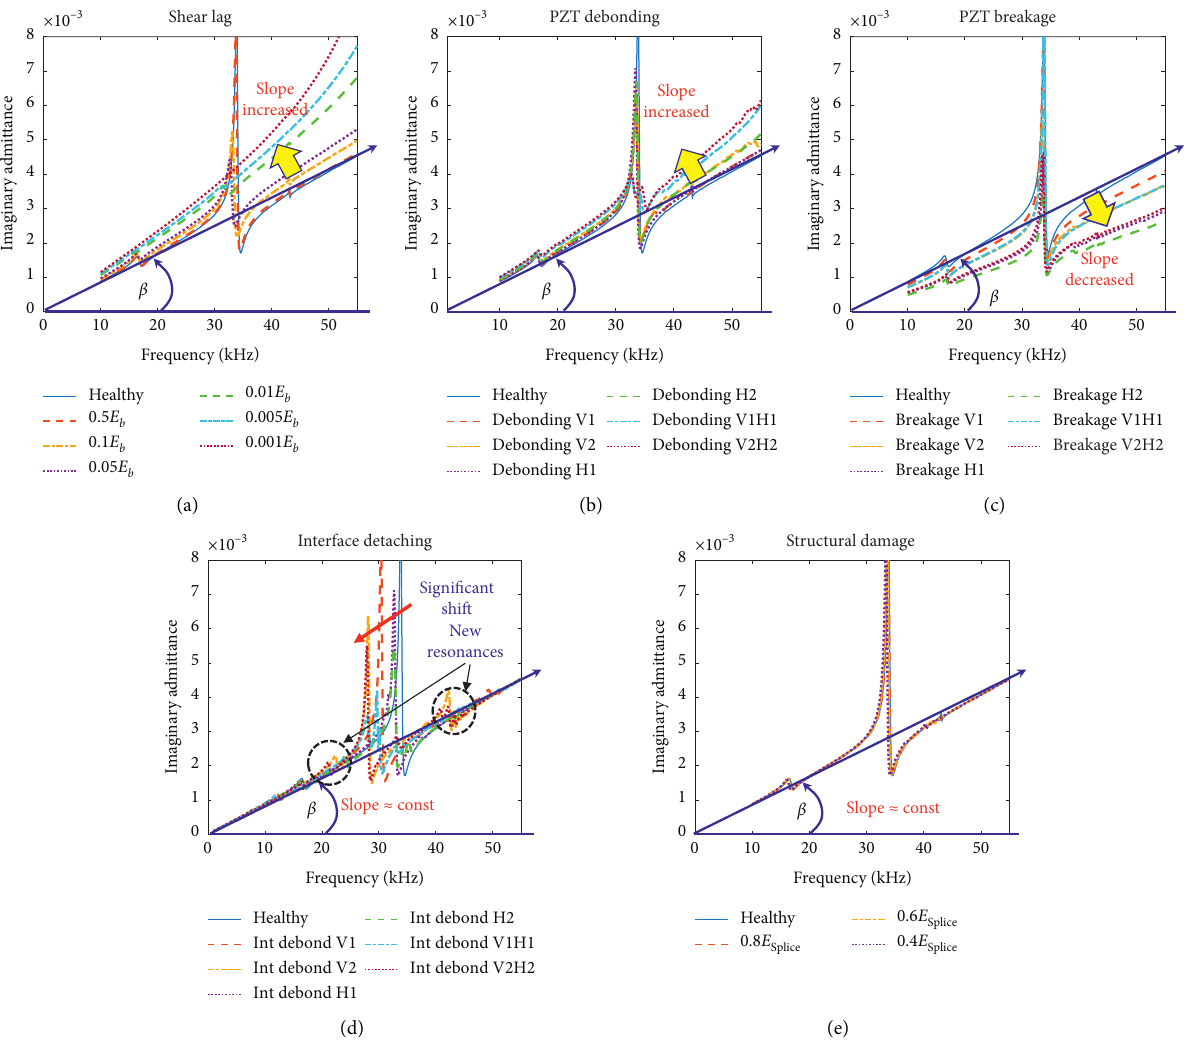
Figure 2: Changes in the slope of imaginary